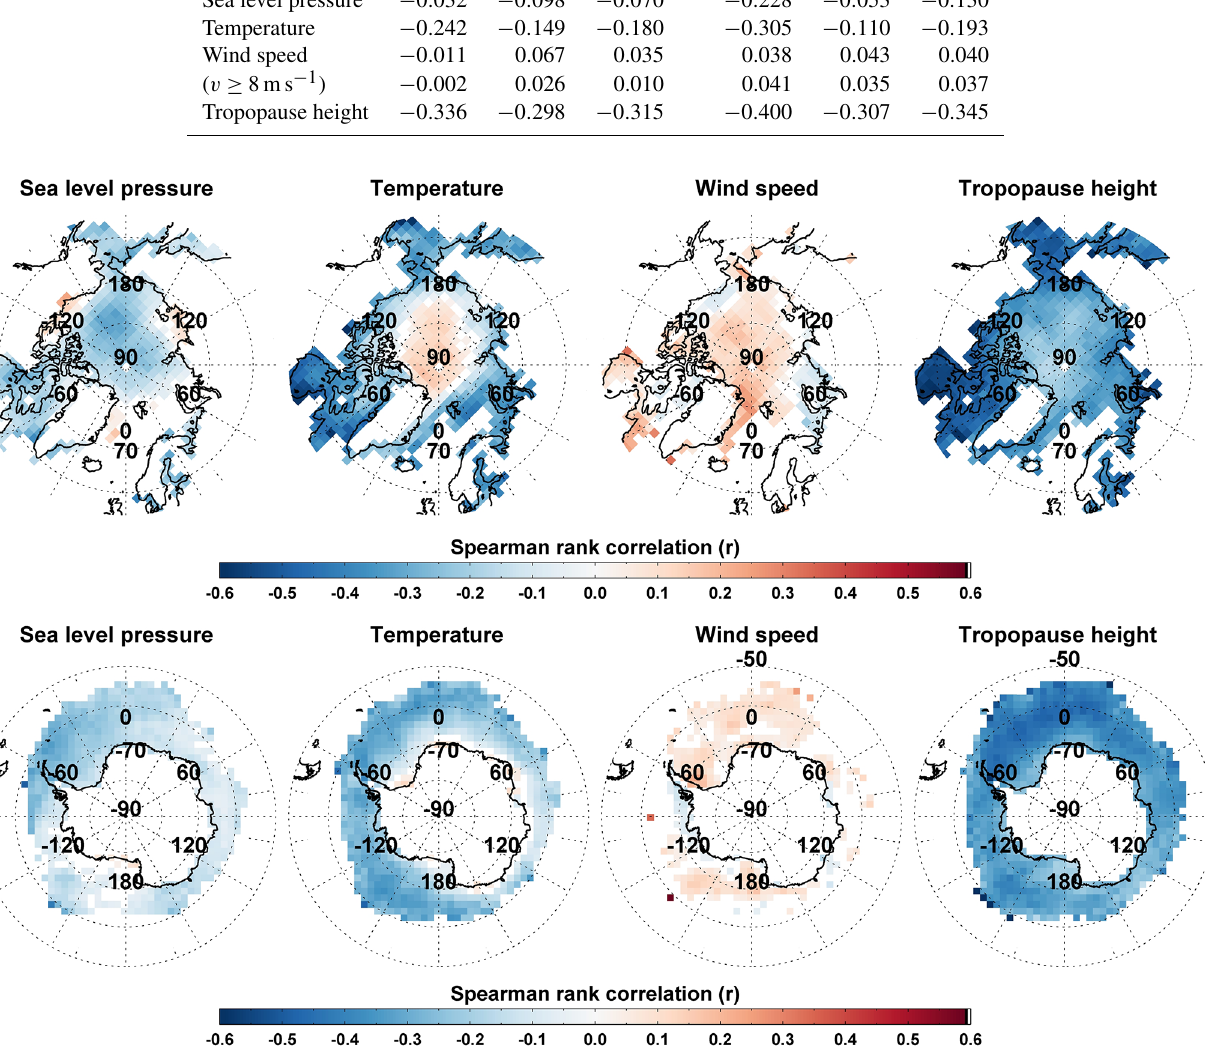
Figure 20. Spatial distributions of the Spearman correlation coefficients between total BrO VCD and four meteorological parameters (sea level pressure, surface air temperature, wind speed at 10m, and tropopause height) for the Arctic and Antarctic in spring. Only Spearman correlation coefficients with p value < 0.001 are